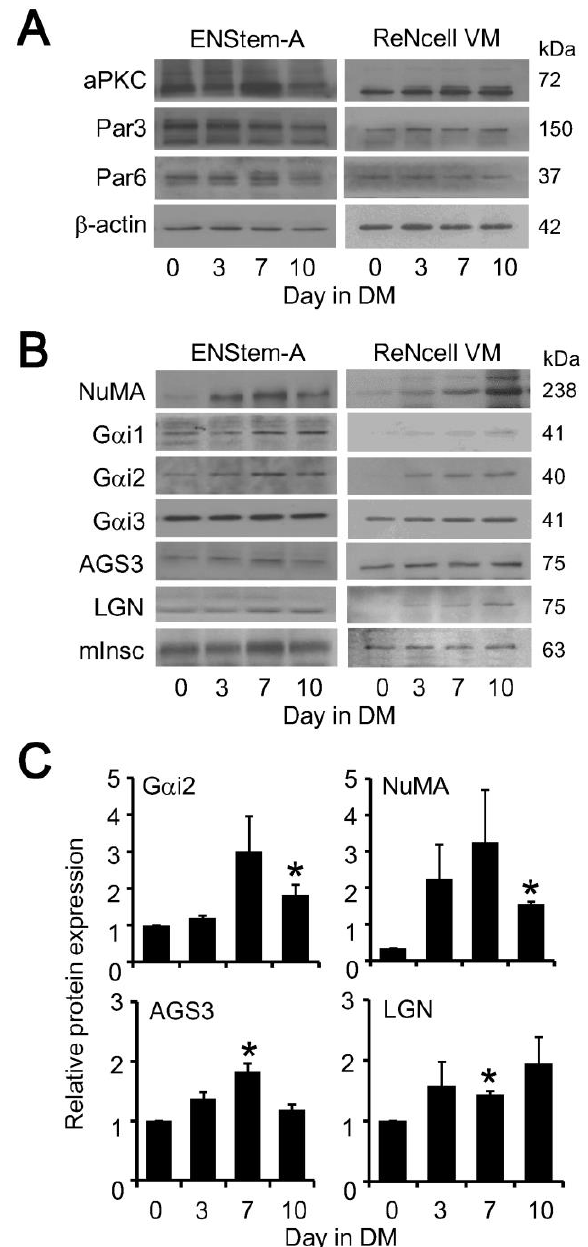
Figure 2. Upregulation of spindle orientation proteins in human neural progenitor cells during di ff erentiation. ENStem-A and ReNcell VM cells were induced to undergo di ff erentiation. Cell lysates were collected at Day 0, Day 3, Day 7 and Day 10 of di ff erentiation. ( A ) Expression of polarity proteins were determined by Western blot analysis using anti-atypical protein kinase C (aPKC), anti-partition defective 3 (Par3), anti-Par6 and anti- β -actin antisera. ( B ) Expression of spindle orientationproteins were assessed by Western blot analysis using anti-nuclear mitotic apparatus (NuMA), anti-G α i1 , anti-G α i2 , anti-G α i3 , anti-AGS3, anti-LGN and anti-inscuteable antisera; please see β -actin immunoreactivity in panel A for reference protein expression. Data shown represent one of three or more sets of immunoblots; other sets yielded similar results. ( C ) Quantitative analysis of the expression of G α i2 , NuMA, AGS3 and LGN using the ImageJ software. Data were expressed as the mean ± S.E. of at least three independent sets of experiments. The probability of an observed di ff erence being a coincidence was evaluated by Dunnett t test. Di ff erences at values of p < 0.05 were considered significant (* p <